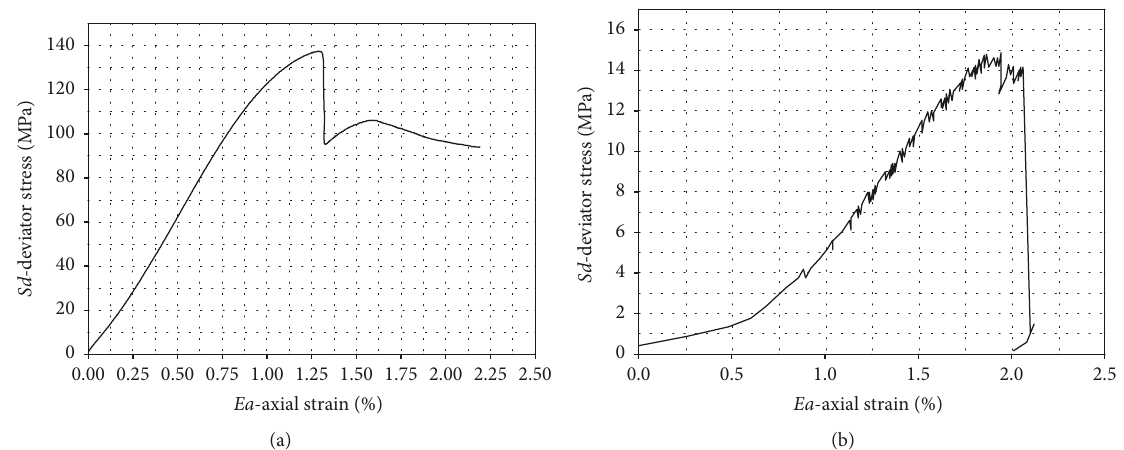
Figure 7: Stress-strain curves of shale under compressive and tensile loading.